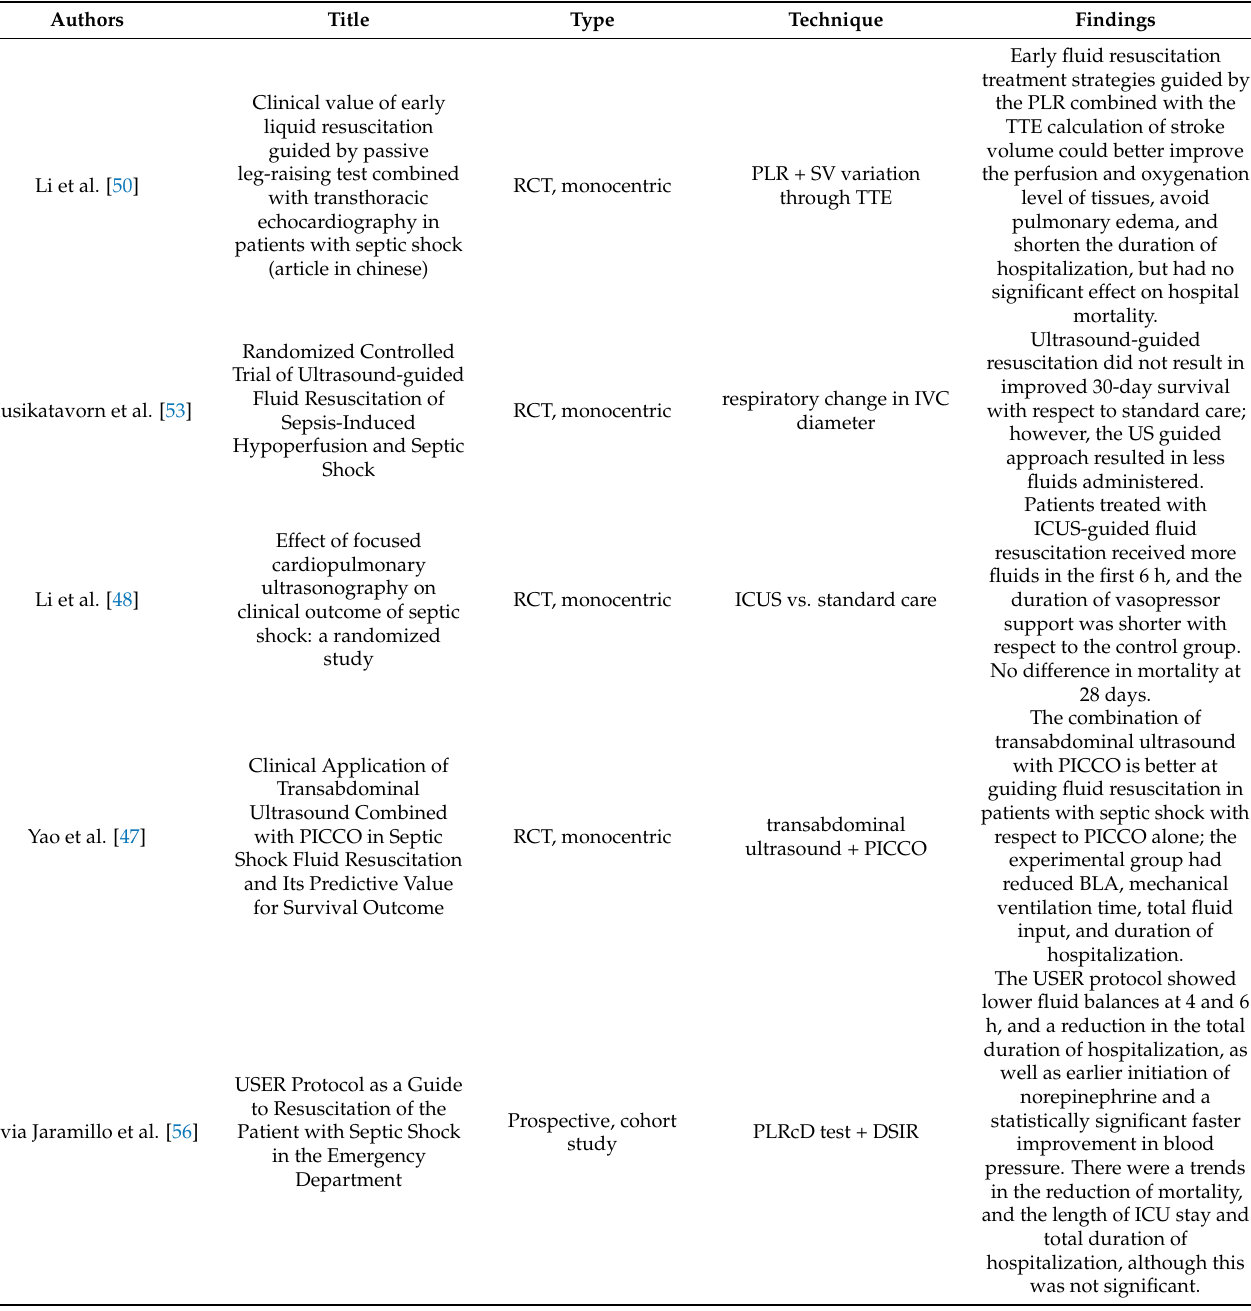
Table 2. This table summarizes the most significant clinical trials which have addressed ultrasound- guided fluid management in septic shock in recent